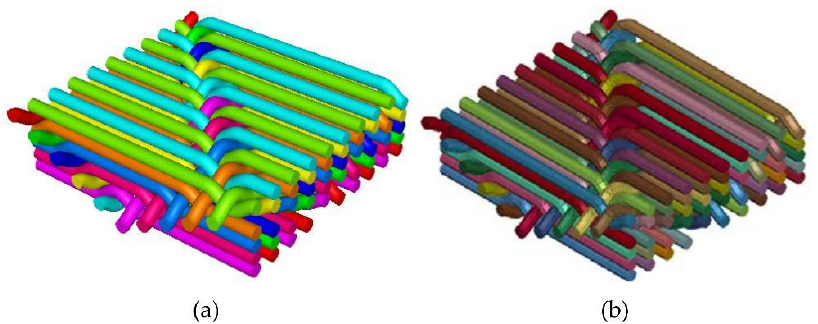
Figure 4. Exemplary model generation for angle-through-thickness weave: ( a ) TexGen model, ( b ) beam element model in LS-DYNA. ( b ) beam element model in LS-DYNA.